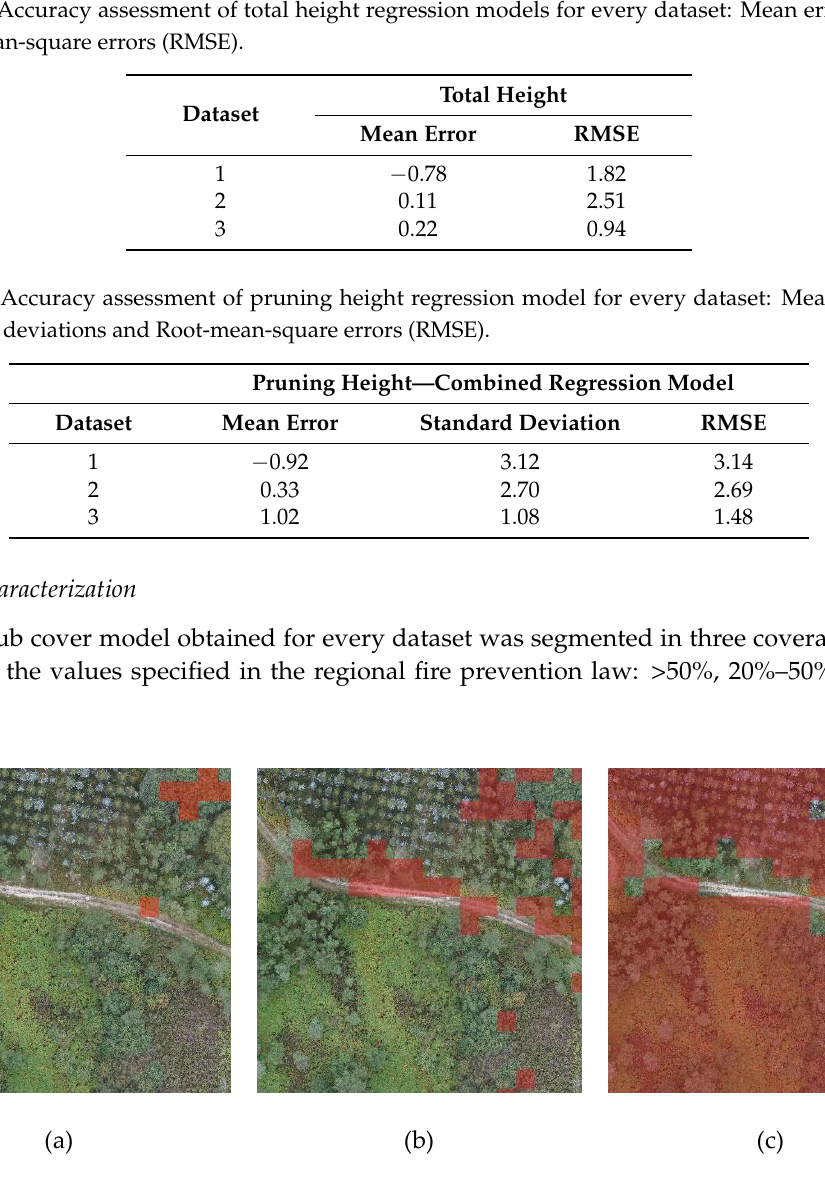
Figure 12. Decision tree, implemented to verify the degree of compliance with the condition of the 384